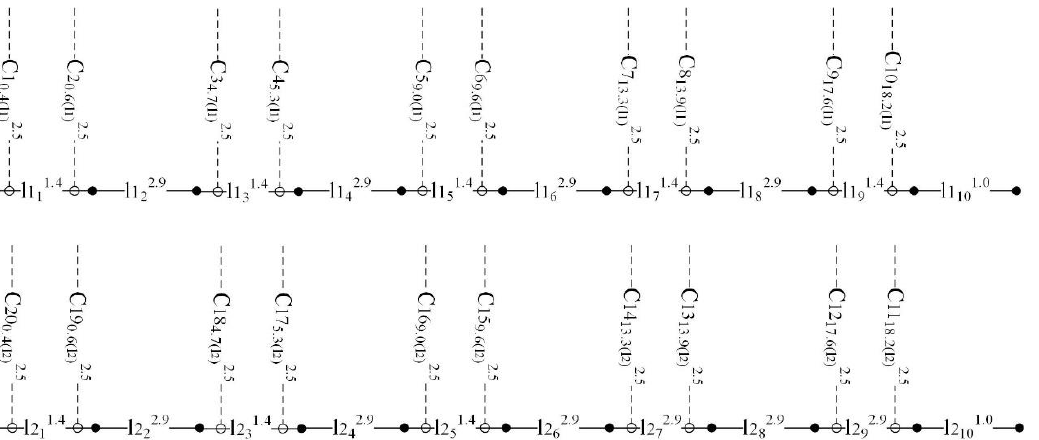
Figure 5. Algorithm for calculating energy consumption.